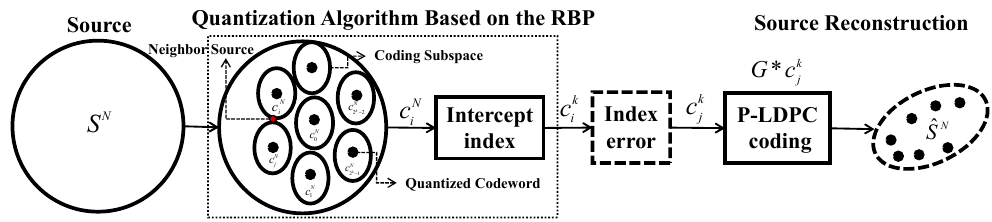
Figure 2. Simplified diagram of system